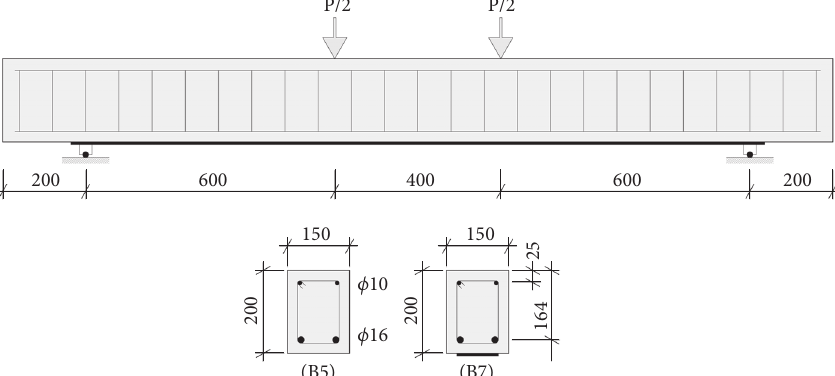
Figure 5: Details of Esfahani et al. beam specimens.